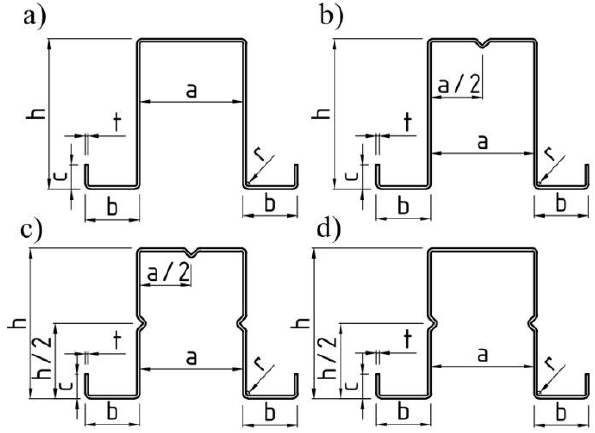
Figure 7: View of analysed hat profiles: a) cross-section without longitudinal stiffeners, b) cross-section with stiffener on upper chord, c) cross-section with stiffeners on webs, d) cross-section with stiffeners on upper chord and webs